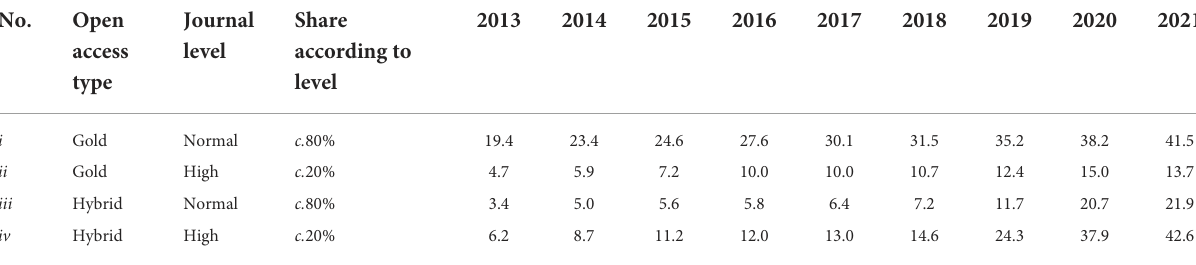
TABLE 3 Relative shares of hybrid and gold on both level normal and high.